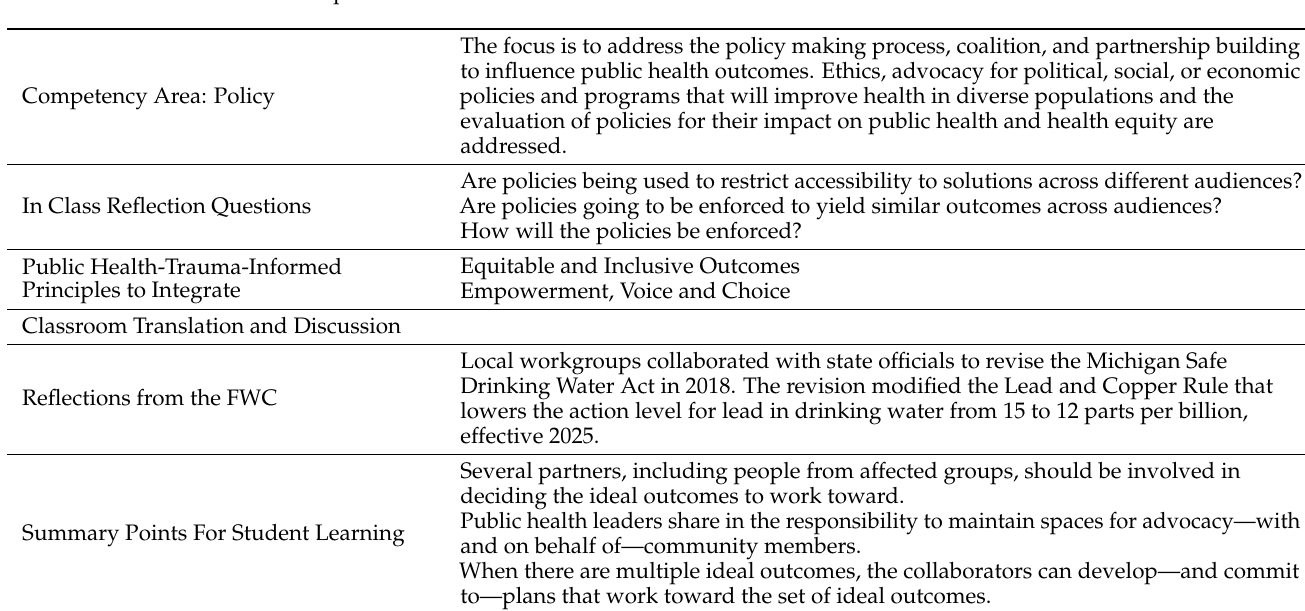
Table 5. Trauma-Informed Principles in Public Health: Addressing Public Health Policy with Exam- ples from the Flint Water